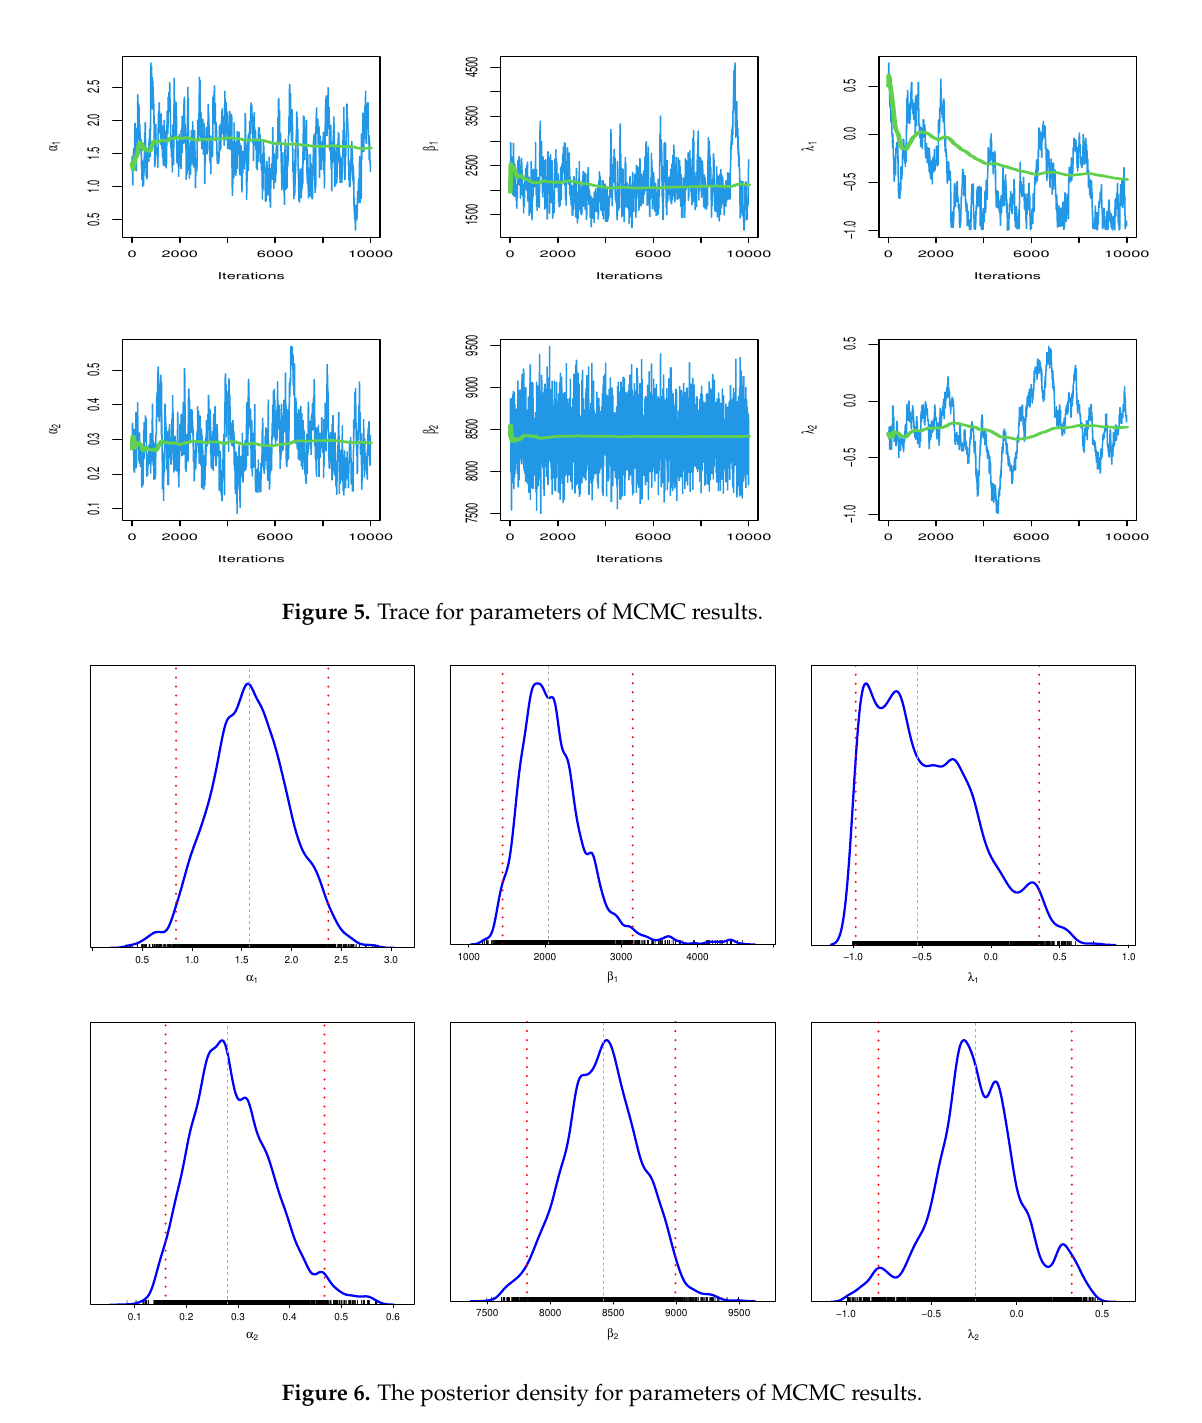
Figure 6. The posterior density for parameters of MCMC results.